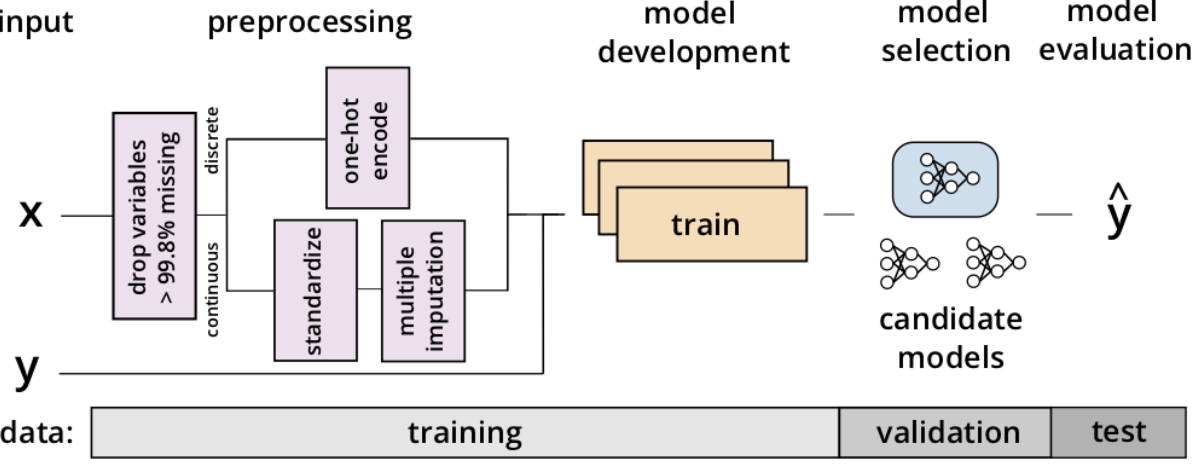
Figure 2. The presented multistage machine learning pipeline consists of preprocessing (light purple) the input data x, developing multiple candidate models using the given data set (orange), selecting the best candidate model for evaluation (blue), and evaluating the selected best model's outputs ŷ